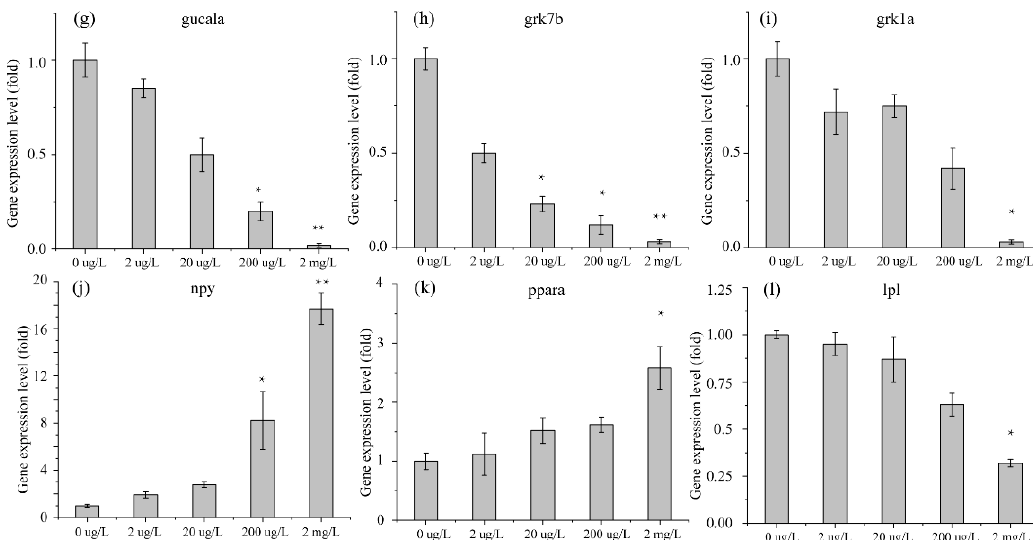
Figure 8. The effects of erythromycin on the mRNA expression of genes in D. rerio and O. latipes . (( a – c ) gene in D. rerio ’s muscle; ( d – f ) gene in O. latipes ’s muscle; ( g – i ) gene in D. rerio ’s head; ( j – l ) gene in O. latipes ’s head) Values represent the mean ± SD (n = 3 replicates). * indicates p < 0.05 relative to the